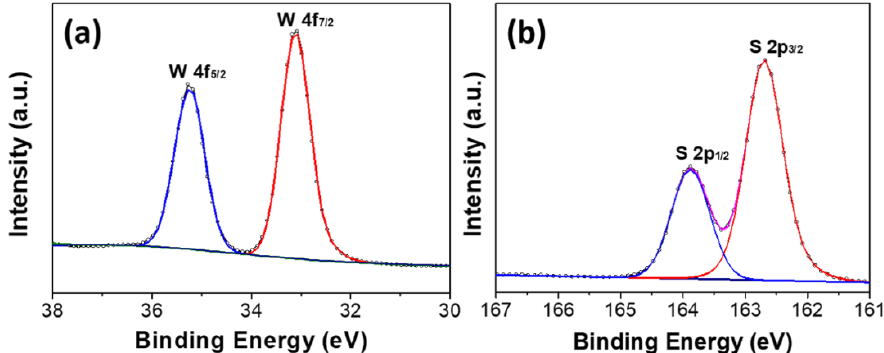
Figure 5. X-ray photoelectron spectroscopy (XPS) spectra of two-dimensional (2D) WS 2 nanosheets at 550 °C and ( a ) W 4f and ( b ) S 2p regions.